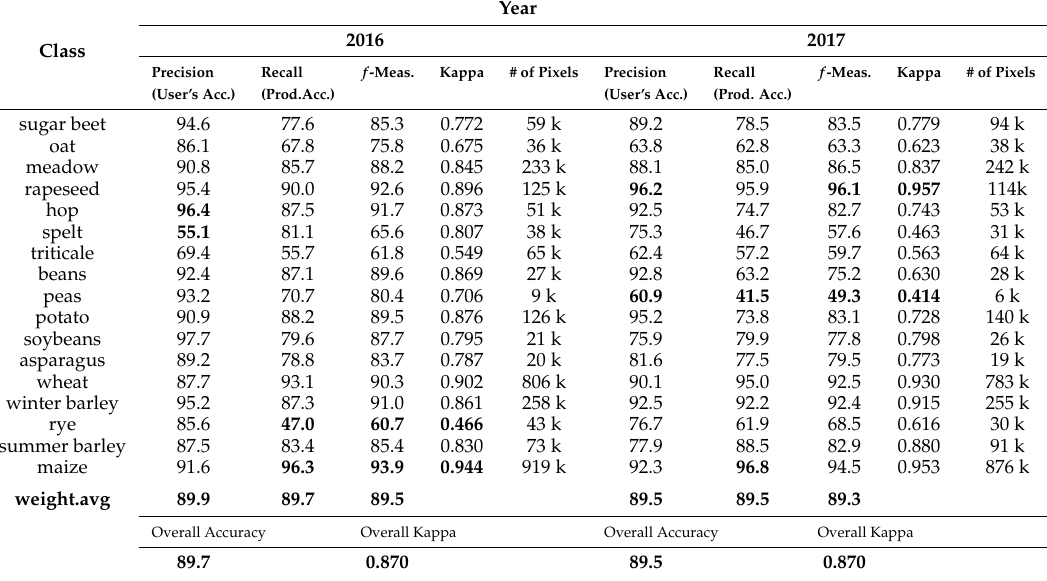
Figure 7. Confusion matrix of the trained convolutional GRU network on data of the seasons 2016 and 2017. While the confusion of some classes was consistent over both seasons (e.g., winter triticale to winter wheat), other classes are classified at different accuracies for consecutive years (e.g., winter barley to winter spelt). Table 2. Pixel-wise accuracies of the trained convolutional GRU sequential encoder network after training over 60 epochs on data of both growth seasons. The conditional kappa metrics [42] for each class and the overall kappa [40] measure are given for both growth seasons. The best and worst metrics are emphasized by